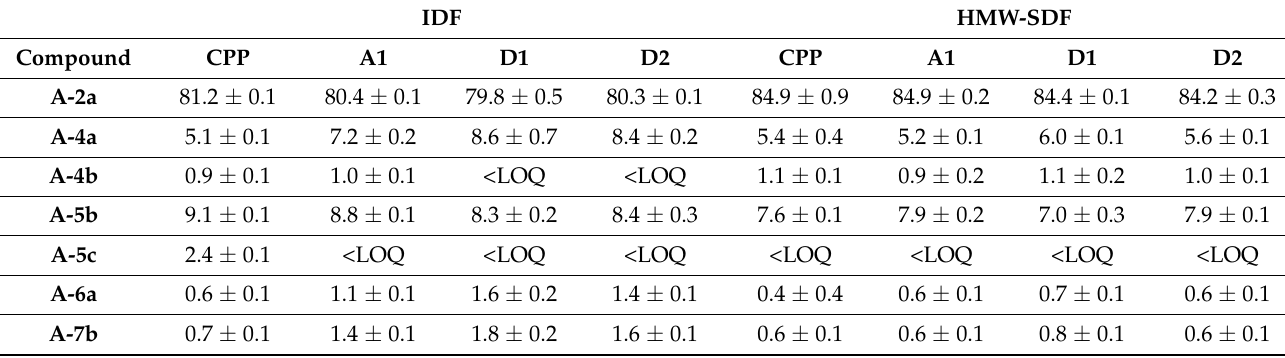
Table 4. Relative composition of pectic arabinan oligosaccharides liberated from chokeberry pomace powder (CPP) and extruded dietary fiber (DF) fractions 1 after enzymatic cleavage using endo-arabinanase (mol%, range/2, n = 2). IDF, insoluble dietary fiber; HMW-SDF, high molecular weight dietary fiber. IDF